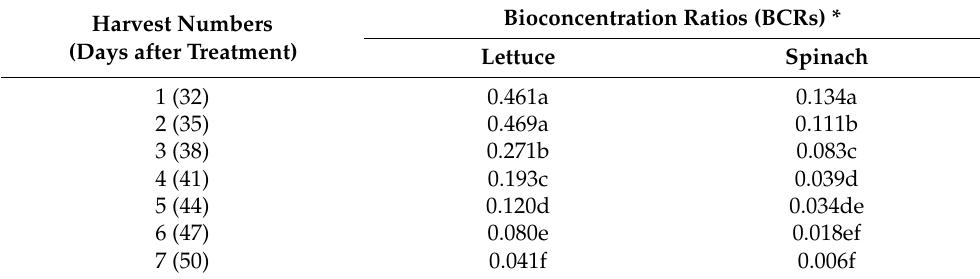
Table 5. Bioconcentration ratios (BCRs) of imicyafos in the lettuce and spinach